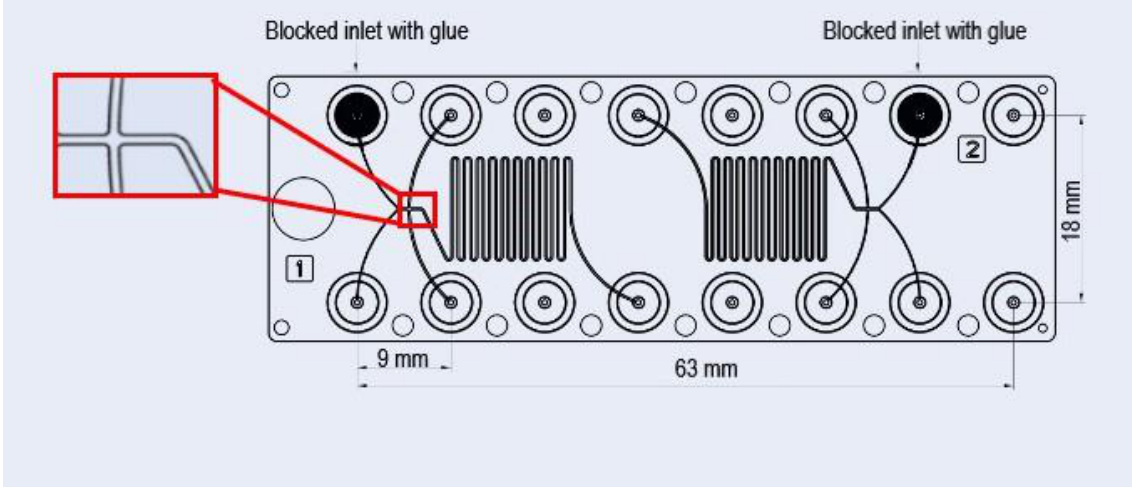
Figure 1. A schematic representation of the used commercial microfluidic hydrodynamic flow focusing polycarbonate chip. The dimensions of the microchannels are 100 µm depth, 100 µm core inlet channel width, 200 µm lateral inlet channel width, 200 µm mixer channel width, and 200 µm output channel width.